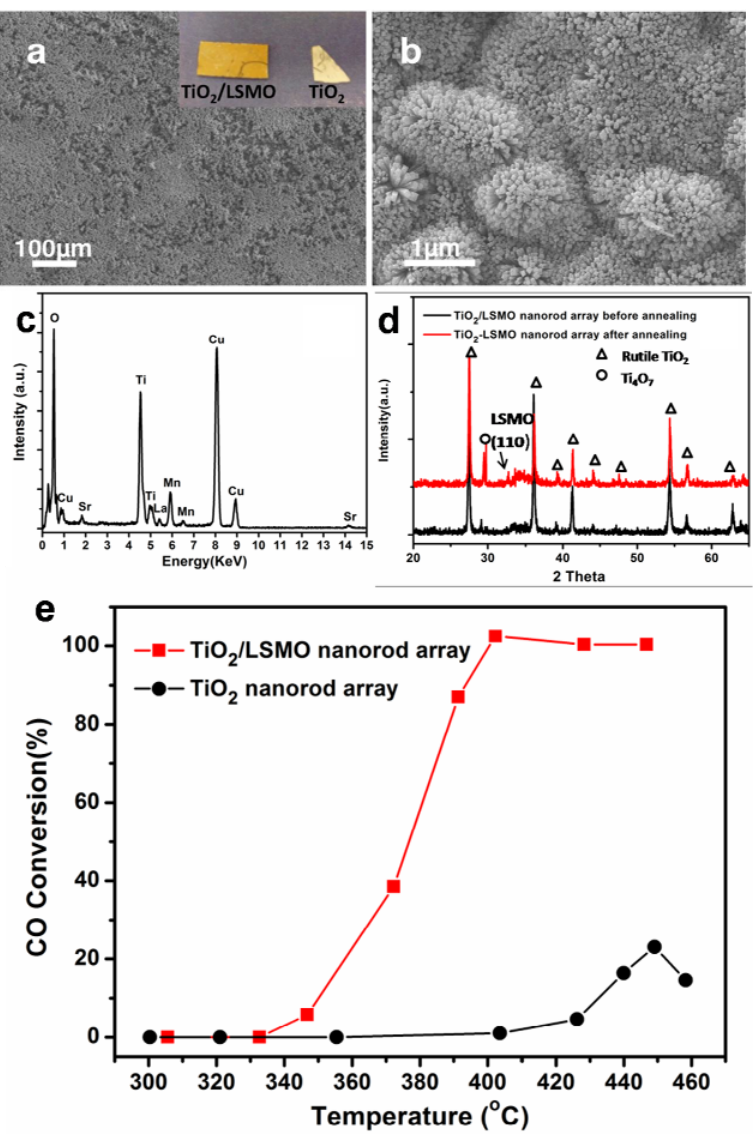
/LSMO nanorod 2 /LSMO nanorod array and 2 /LSMO 2 /LSMO 2 /LSMO composite 2 nanorod 2